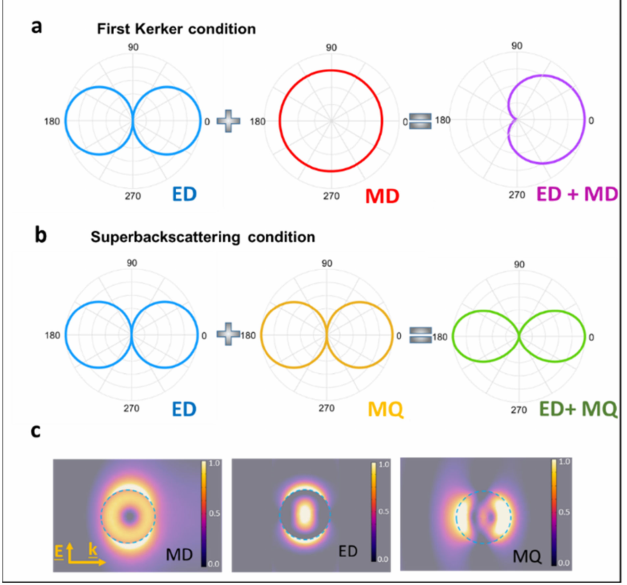
Figure 2. Illustrating the concept of ‘mode-stacking’ where two or more modes are superimposed spectrally and their far field patterns interfere to control the directivity of scattering (or radiation) from a dielectric sphere [16]. ( a ) The combination of electric and magnetic dipoles (ED + MD, first Kerker condition), leading to constructive interference in the forward direction and destructive in the reverse. ( b ) Shows the combination of the electric dipole and magnetic quadrupole (ED + MQ) where the emission is bidirectional and scattered power in the reverse direction is maximized (a ‘superbackscattering’ condition [22]). ( c ) Shows Comsol simulations of the normalised electric near-fields of these three modes. The field distributions provide clues as to how these modes can be tuned separately to achieve an overlap